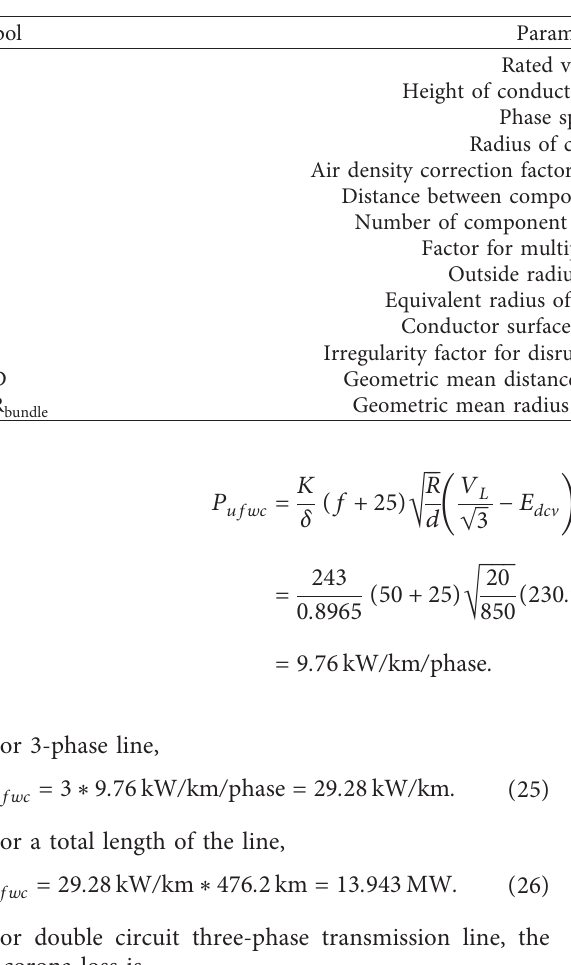
Table 2: HVAC corona loss calculation